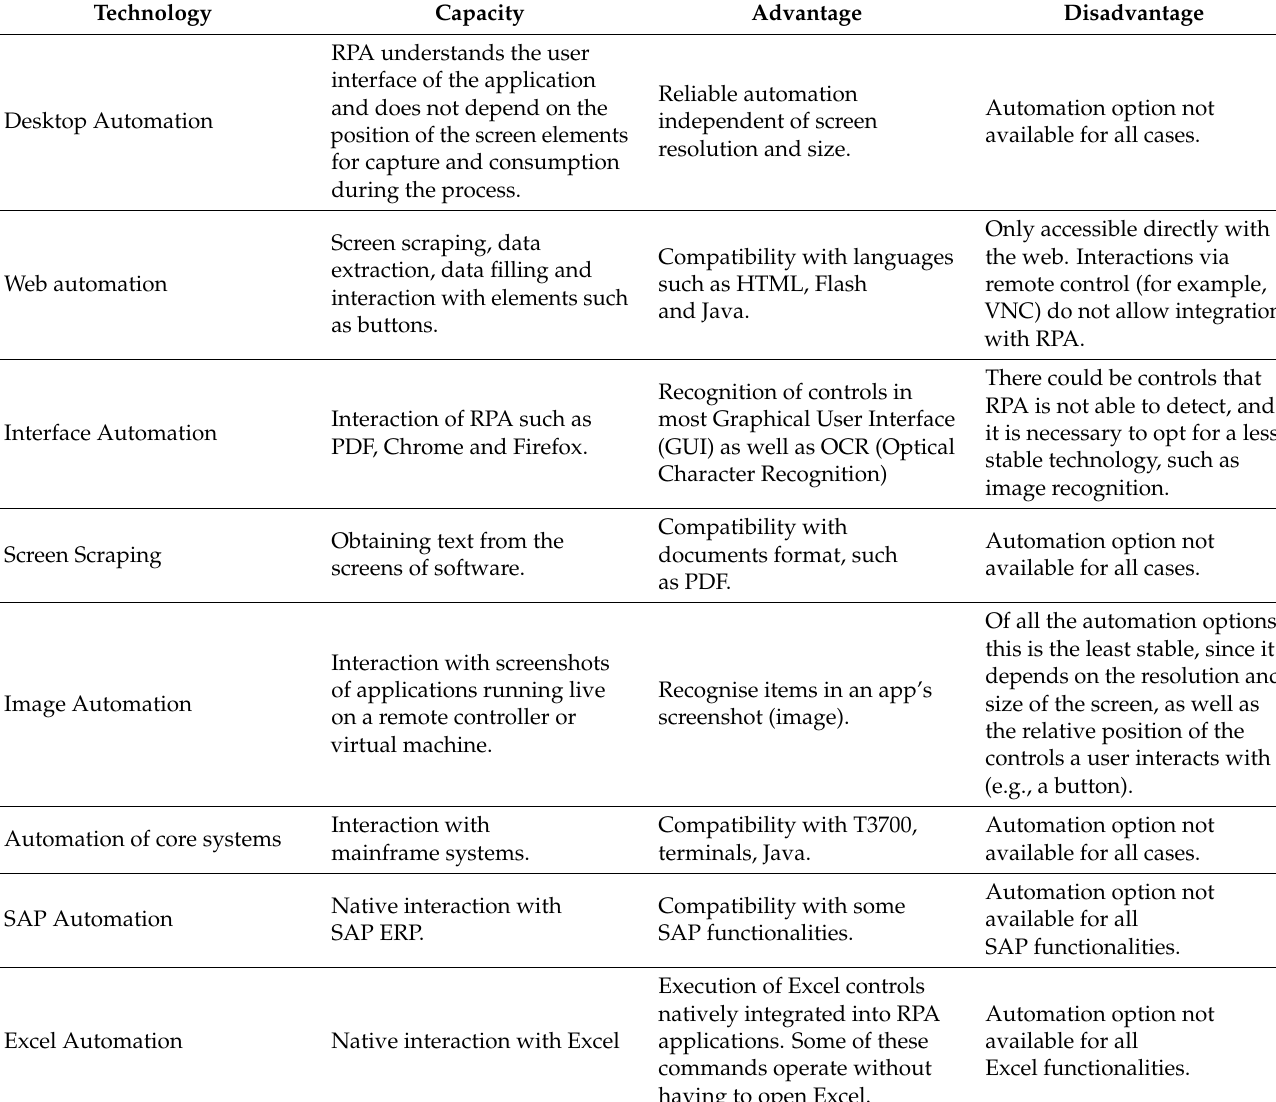
Table 2. Sub-technologies used in RPA